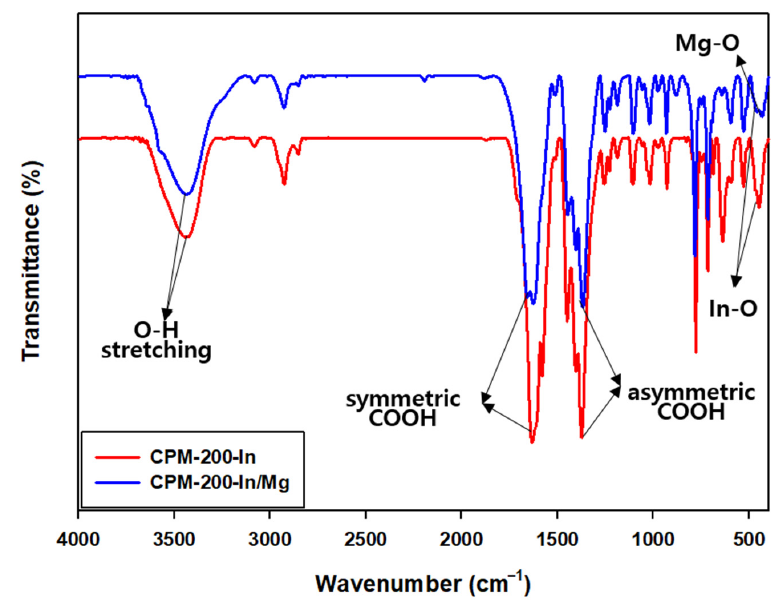
Figure 3. FT-IR spectrum of CPM-200-In and CPM-200-In/Mg. TGA results of CPM-200-In and CPM-200-In/Mg (Figure 4) showed an initial weight loss of solvent inside their pores around 130 °C and 200 °C. Even after the initial weight loss, CPM-200-In/Mg exhibited better thermal stability than CPM-200-In, probably due to the better crystallinity from the synergy effect of two metals during CPM-200-In/M crys- tallization process [60] and/or to the smaller micropore diameter for CPM-200-In/M com- pared to CPM-200-In. Figure 4. TGA curve of CPM-200-In and CPM-200-In/Mg.